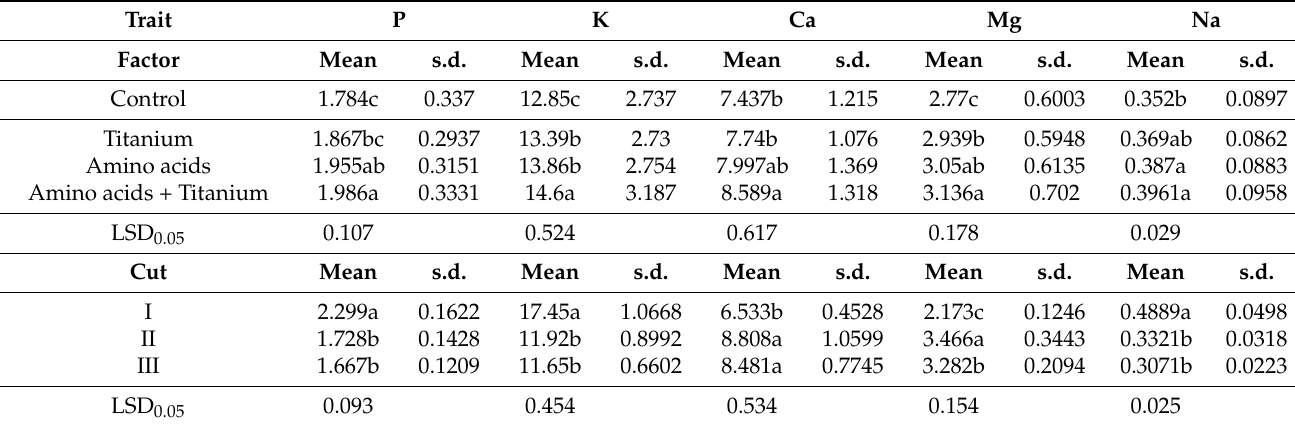
Table 3. Mean values, standard deviations (s.d.), Fisher’s least significant differences (LSD) and homogeneous groups of